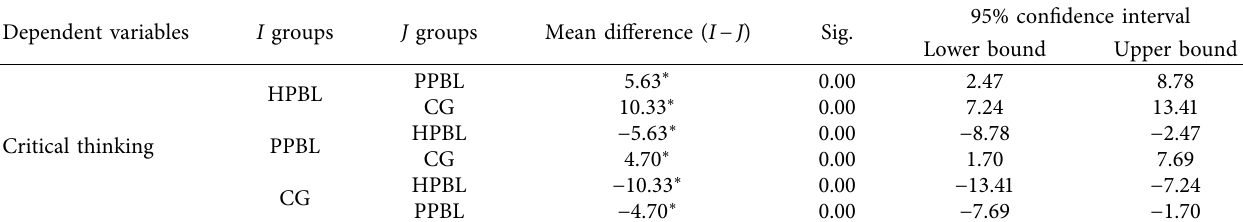
Table 11: Results of post hoc test for the type of instruction and critical